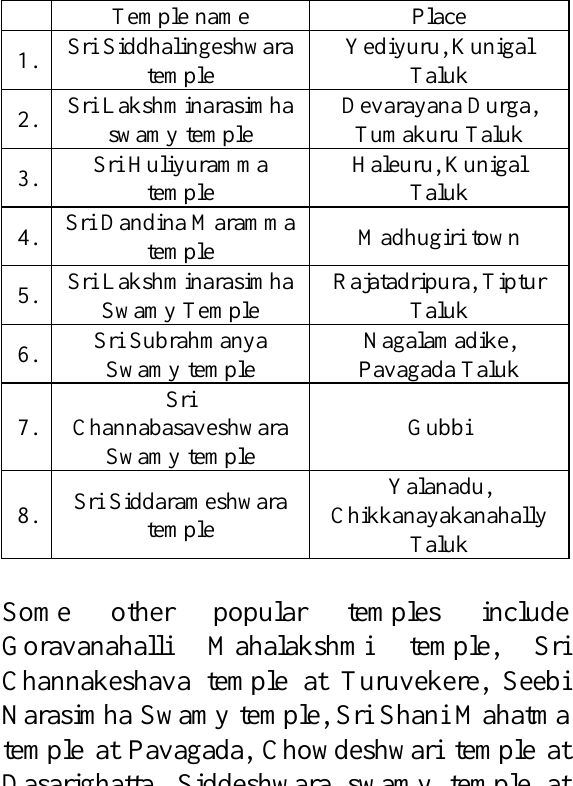
Table 2. List of A Grade temples in Tumakuru